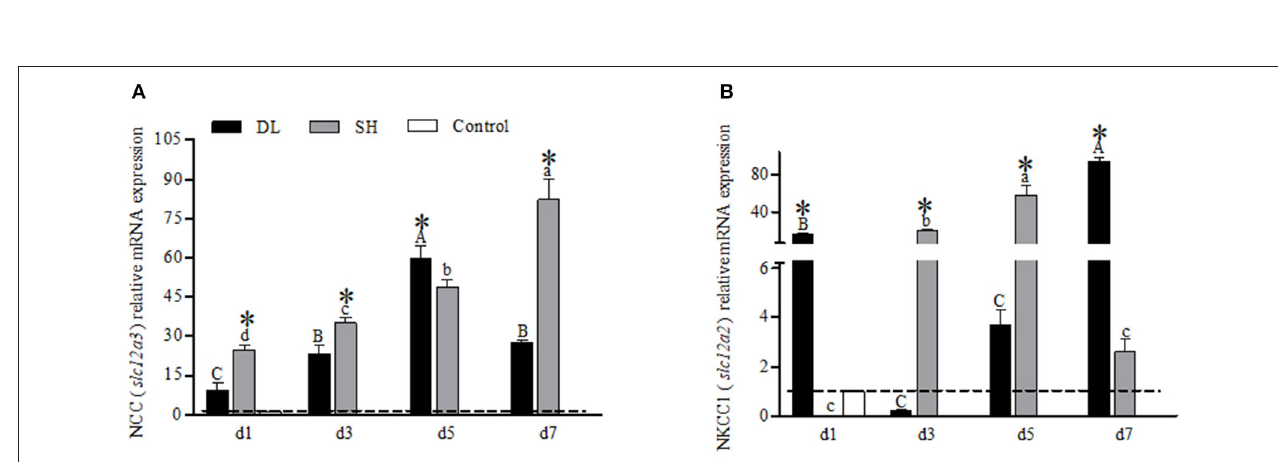
FIGURE 6 | Gill NCC ( slc12a3 ) and NKCC1 ( slc12a2 ) mRNA levels ( n = 3) for DL (the alkali form introduced from Lake Dali Nor) and SH (the freshwater form introduced from Songhua River) fish forms. Different uppercase letters indicate significant differences within DL, and different lowercase letters indicate significant differences within SH. The asterisk (*) denotes a significant difference found in the NCC or NKCC1 mRNA levels between DL and SH exposed to bicarbonate